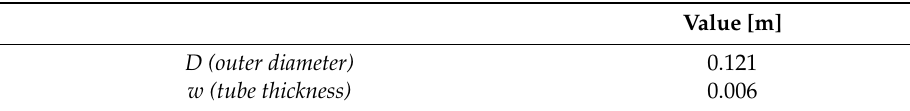
Table 4. Dimensions of the tube.